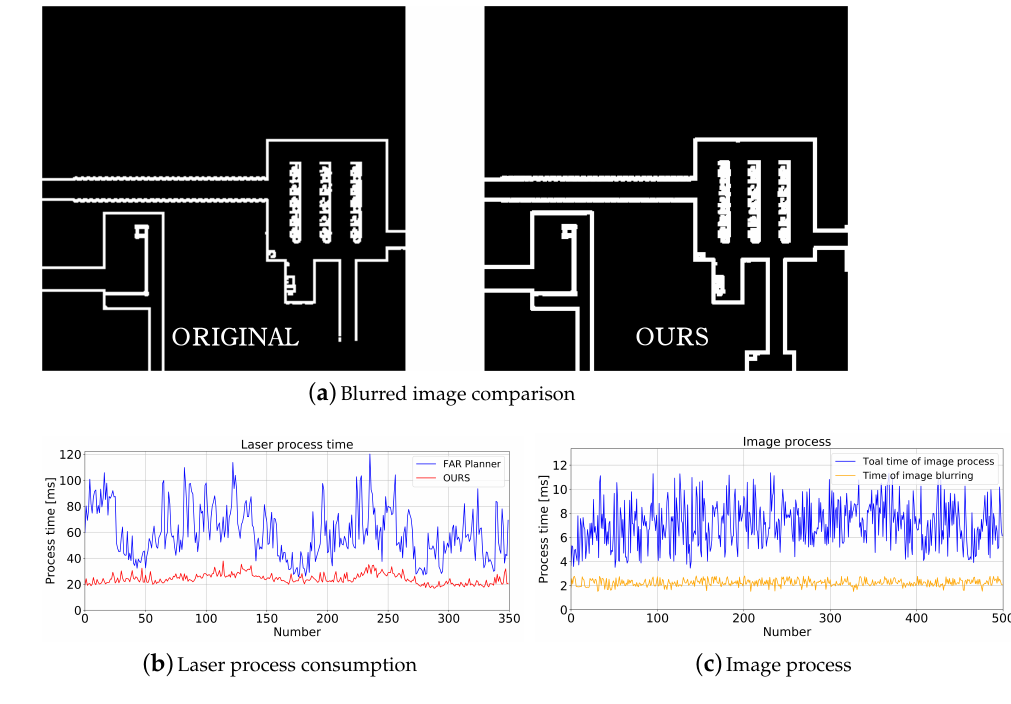
Figure 7. ( a ) shows blurred images, the vertices of the obstacle will be extracted through the blurred image. The FAR Planner generates images without holed structure, and ours generates pictures through the holed structure. ( b ) shows the consumption of the laser process and ( c ) shows the consumption of the image